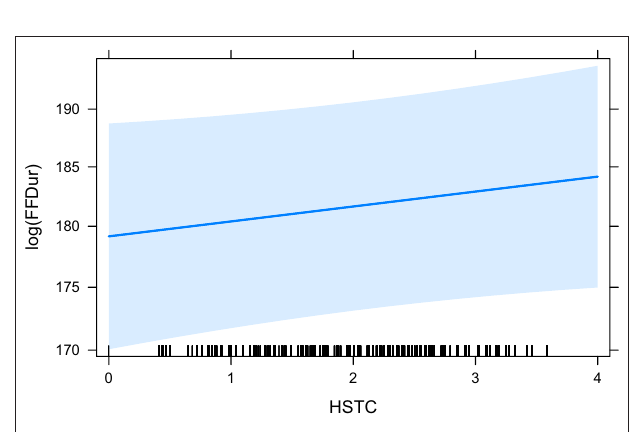
FIGURE 5 | The effect of HSTC on the logarithm of FFDur.